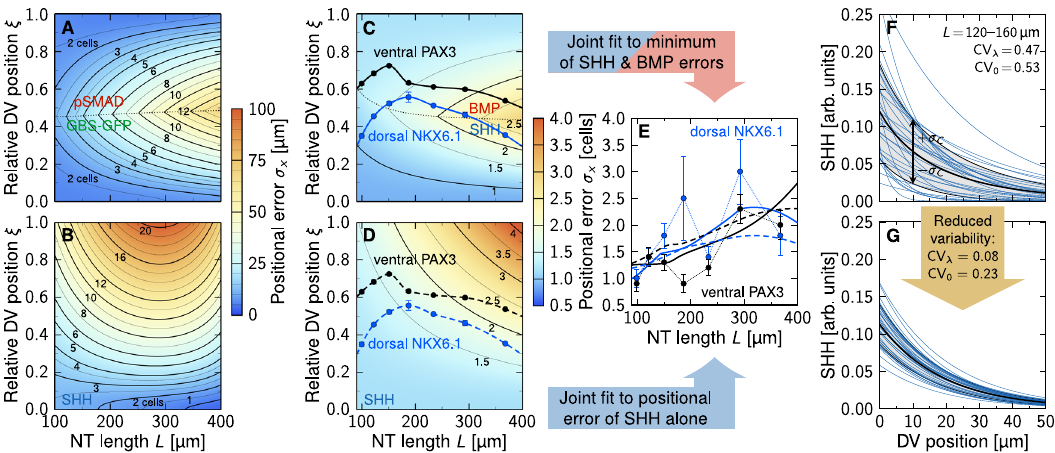
Fig. 6 Gradient and readout imprecision in the developing neural tube. A , B Contour plots of the positional error σ x (Eq. (10)) using reported GBS-GFP and pSMAD ( A ) and SHH ( B ) parameters from Table 1, as a function of the relative position along the DV axis, ξ = μ x / L , and the NT length, L . With the reported gradient variability, the positional error of the opposing SHH and BMP gradients is in the order of several cell diameters. C , D Dorsal NKX6.1 (blue) and ventral PAX3 (black) domain boundary positions, overlaid on the gradient precision contours obtained by fi tting Eq. (10) to the measured positional errors of the boundaries ( E ). A and C Show the case where the positional error is the minimum of the two opposing gradients; the dotted line divides the NT into two parts in which either SHH or BMP provide higher accuracy. B and D Use only the SHH gradient. Black contours in ( A – D ) trace cell diameter isolines as labeled. E Reported (symbols) and predicted boundary precision if the domain boundaries are either set by SHH and BMP (solid lines, C ) or by SHH alone (dashed lines, D ). Domain boundary data in ( C – E ) are presented as mean values± SEM calculated as detailed in Methods from n = 18, 42, 31, 6, 24, 13, 13 measurements for dorsal NKX6.1 and n = 22, 33, 42, 15, 32, 38, 28 for ventral PAX3, reproduced from 9 . F , G The exponential SHH gradients with { λ i , C 0, i } as reported in 9 are widely scattered in early NT development. The SHH gradients that match the measured positional error of the readouts ( C , E ) are still variable, but do not contain outliers. The black line represents the mean gradient, shaded areas show standard deviations σ C . Source data are provided as a Source Data fi lines in Fig. 6C, D) and measured positional errors (data points in Fig. 6E) along the boundary positions (black & blue data in Fig. 6C, D) yielded optimal values for the gradient variability,